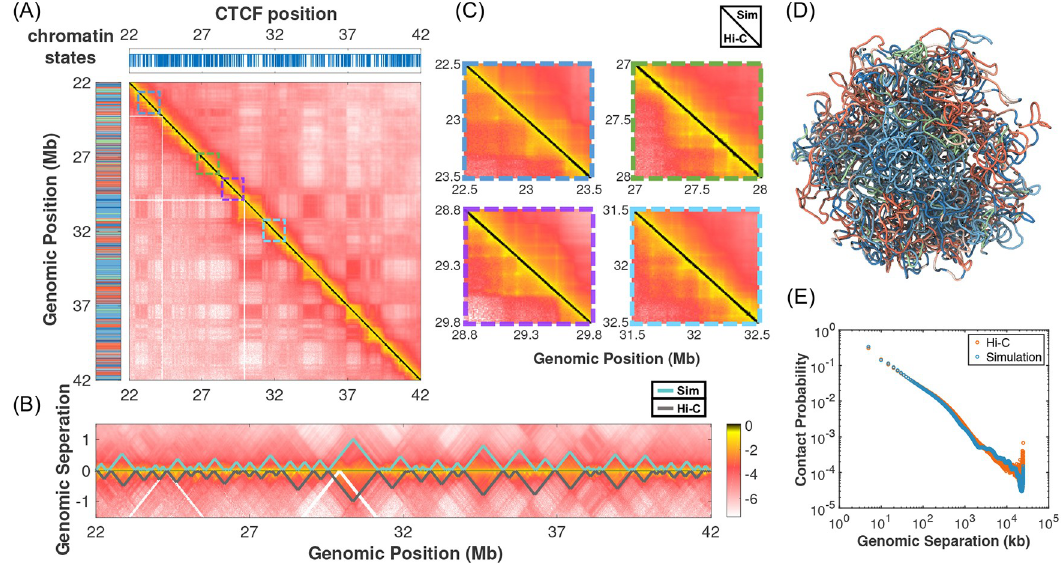
Fig 2. Comparison between simulated and experimental contact probability maps for a 20 Mb segment of chromosome 1 from GM12878 cells. (A) Results from simulation and the Hi-C experiment performed in Ref. [7] are shown in the upper and lower triangle respectively on a log scale. Also shown on the left and top panels are the sequence of chromatin states and the genomic positions of CTCF binding sites. (B) A zoomed-in view of the contact maps along the diagonal region to highlight the formation of TADs. TAD boundaries detected using the software TADbit are plotted on the top of the contact map, with the simulation shown in cyan and experiment in grey. (C) Zoomed-in view of several representative regions along the diagonal to highlight the formation of chromatin loops. (D) A representative chromatin structure predicted by the computational model is drawn in a tube representation and colored by chromatin states. (E) The average contact probability as a function of the genomic separation is shown below on a log-log scale for the simulated (blue) and experimental (red) contact maps